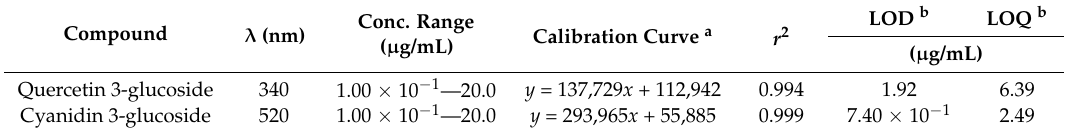
Table 2. Calibration data used for the ultra-high-pressure liquid chromatography coupled with ultraviolet detection (UHPLC-UV) quantification of phenolic compounds in S. nigra L. polar berry